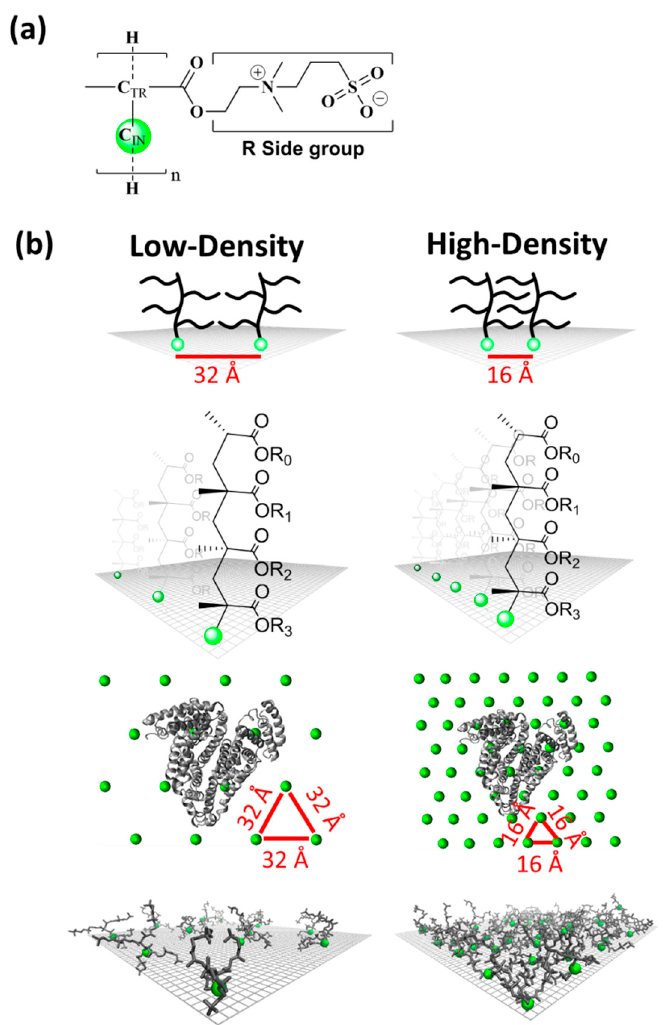
Figure 1. ( a ) Chemical structure of poly(SPE) repeating unit. ( b ) Top to bottom: Two types of distances that allow poly(SPE) chains to interact with each other via the R side groups, Poly(SPE) representations of one “row” and the positions for all the polymer chains within the models (bottom) of low- and high-densities surfaces. The green spheres are C IN atoms of R 3 side groups. The size of the two-dimensional surface was designed due to the size of the chosen foulant: BSA protein. The maximal diameter size of BSA is ~70 Å. In addition, each surface was extended by 15 Å along the edges of the horizontal plane xy axis of each surface. Therefore, the dimension for each constructed surface in plane xy axis was set to ~100 × 100 Å